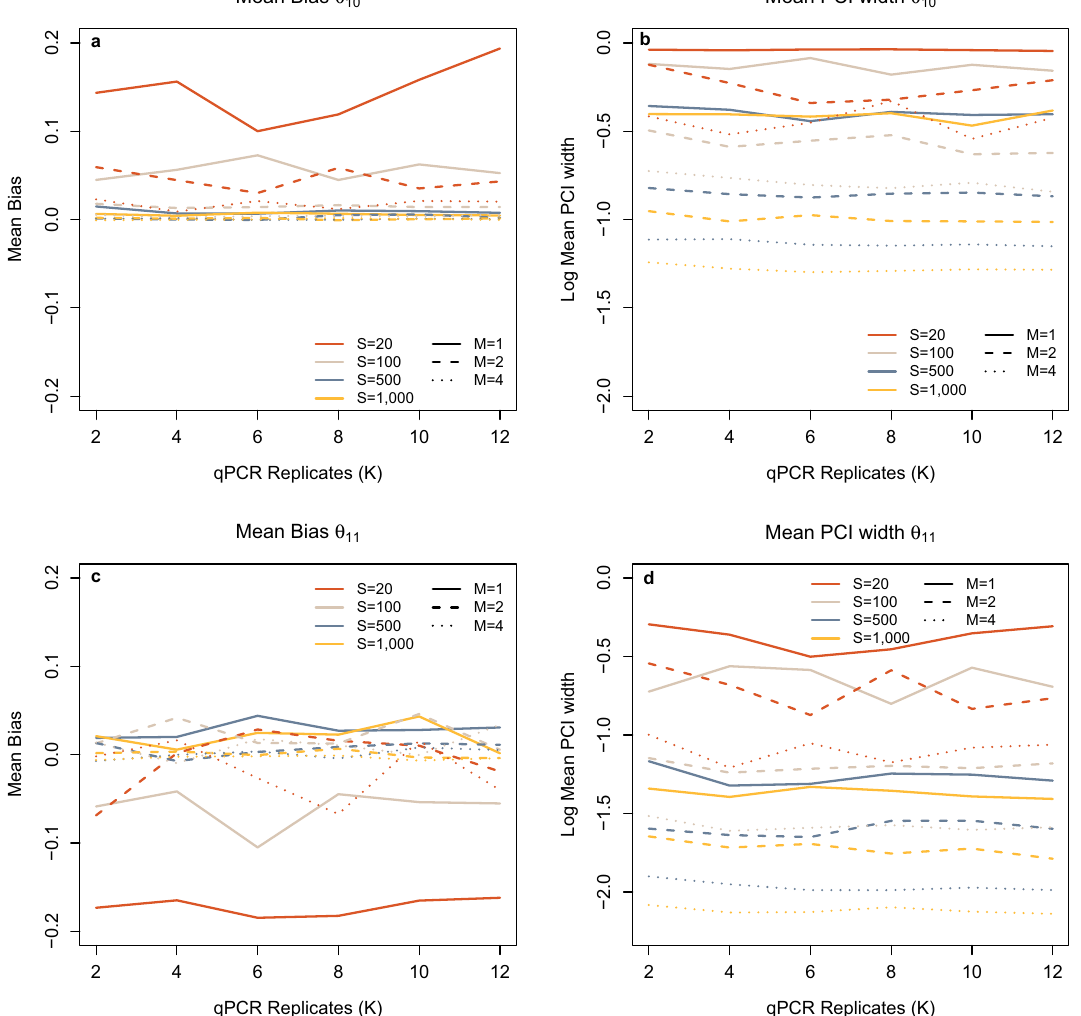
Figure 3. ( a ) Mean Bias in Stage 1 false positives ( θ 10 ) estimate with varying numbers of sites (S), samples collected (M) and qPCR replication (K). ( b ) Mean 95% PCI width for Stage 1 false positives ( θ 10 ) plotted on a logarithmic scale, with varying numbers of sites (S), samples collected (M) and qPCR replication (K). ( c ) Mean Bias in Stage 1 true positives ( θ 11 ) estimate with varying numbers of sites (S), samples collected (M) and qPCR replication (K). ( d ) Mean 95% PCI width for Stage 1 true positives ( θ 11 ) plotted on a logarithmic scale, with varying numbers of sites (S), samples collected (M) and qPCR replication